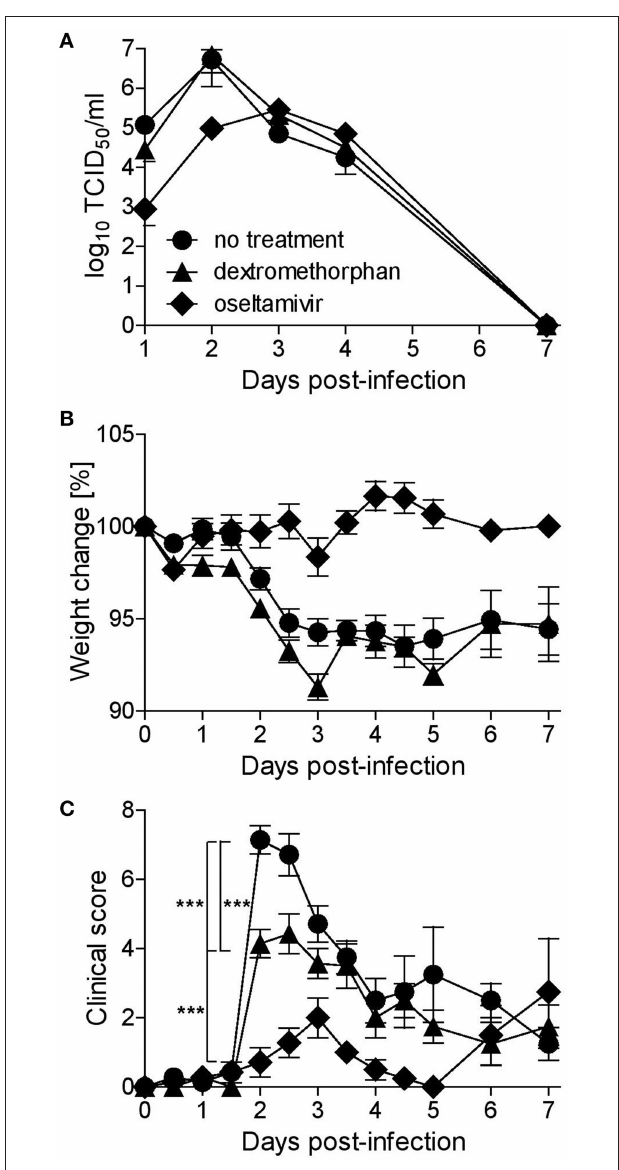
FIGURE 4 | Dextromethorphan efficacy assessment in ferrets. Ferrets ( n = 9) were treated orally every 8h for 5 days or until sacrifice on day 3 ( n = 4), starting 1 day before infection with 2 mg/kg dextromethorphan or 2.5 mg/kg oseltamivir, corresponding to recommended human doses. The animals were infected intranasally with 10 5 TCID 50 of A/Mexico/InDRE4487/2009. (A) Nasal washes were collected daily, and titers were quantified by limited dilution method. For the first 4 days, animals were monitored twice daily and daily thereafter for weight (B) and clinical signs (C) . The clinical score represents a composite score of body temperature, activity, nasal exudate, and respiratory signs scored on a 0-1-2 scale with 0 representing body temperatures ≤ 39.3 ◦ C and the physiologic state, 1 temperatures 39.4–39.9 ◦ C, calm behavior, low amounts of clear exudate, and occasional sneezing or congestion, and 2 temperatures ≥ 40.0 ◦ C, depressed behavior, larger amounts of yellow or brown exudate, and frequent sneezing, coughing and/or dyspnea. Symbols represent group averages, and error bars indicate the standard error mean. One-way analysis of variance (ANOVA) with Tukey’s Multiple Comparison Test was used for statistical analyses (*** p <